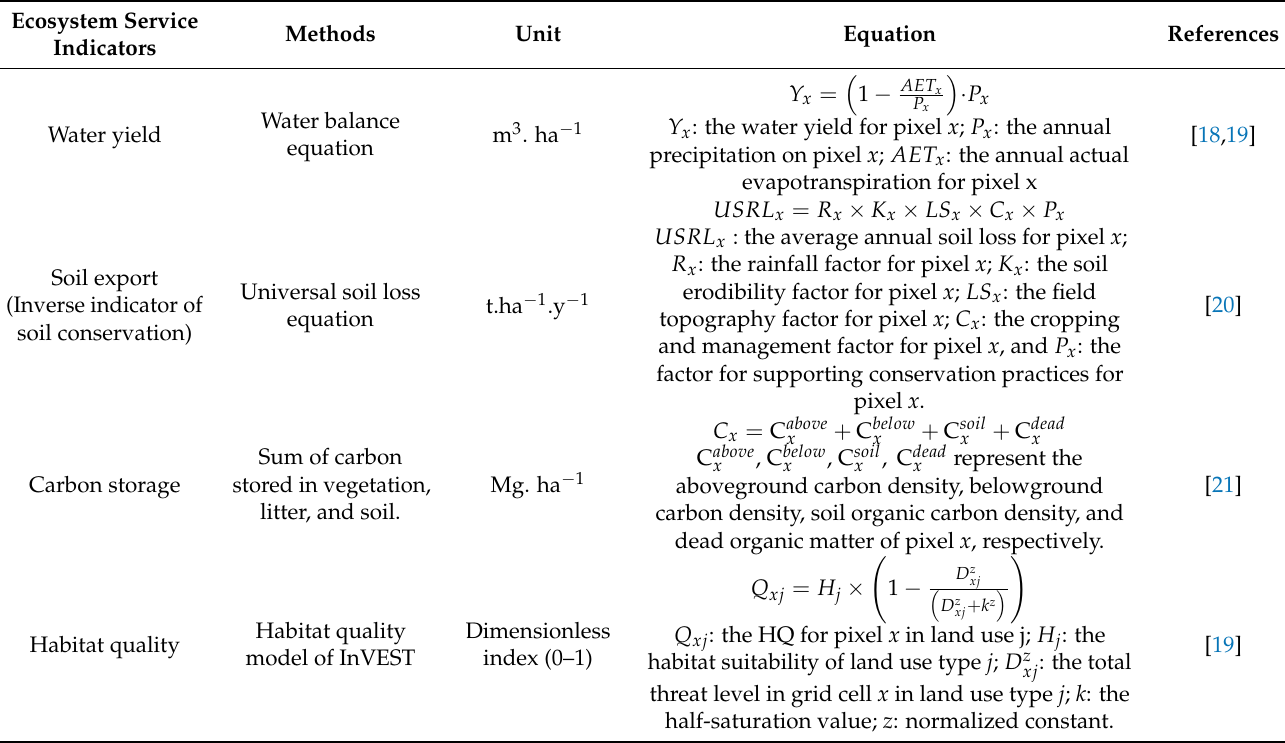
Table 2. Methods for ecosystem services